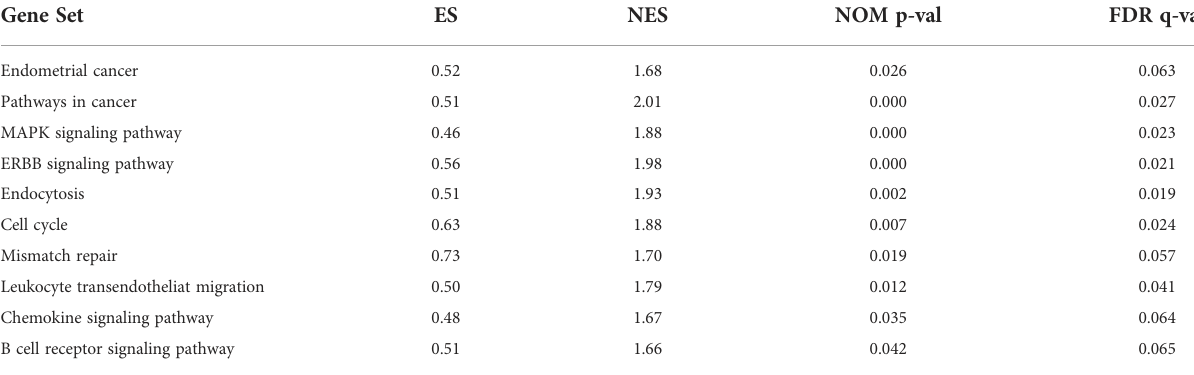
TABLE 1 The high-risk group enriched gene sets.